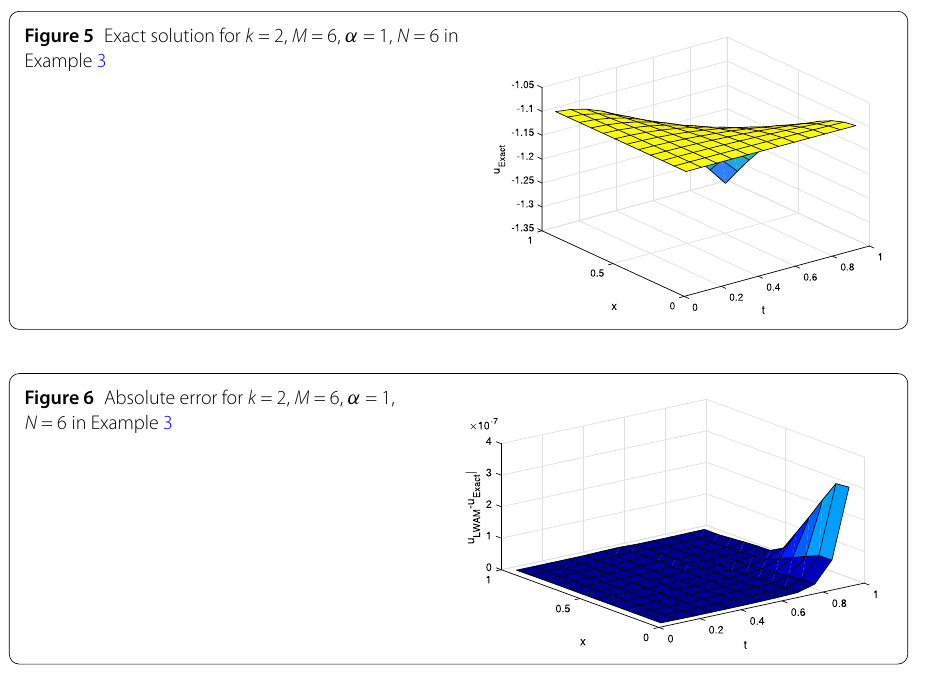
4) Operational Laguerre wavelet matrix is sparse, so solving a system of algebraic